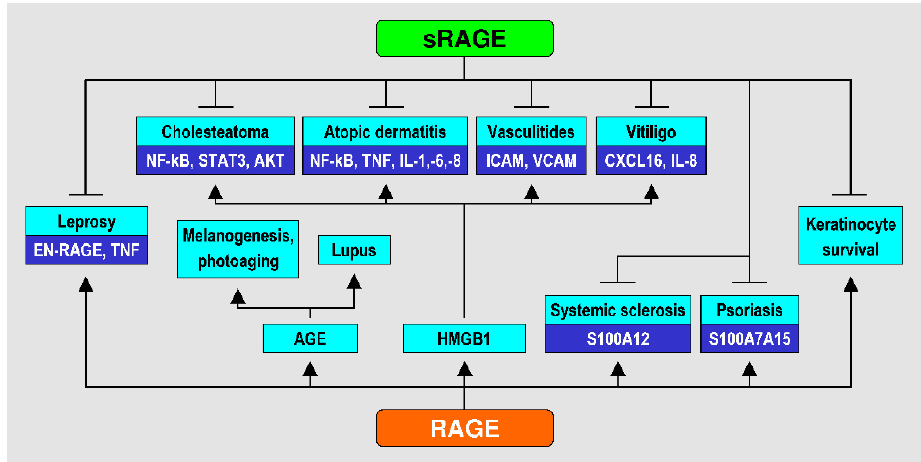
Figure 1. Effects of RAGE and sRAGE in various skin conditions. Table 1. Summary of methods, materials (and their sources), and conditions examined in the studies included in the re- view.